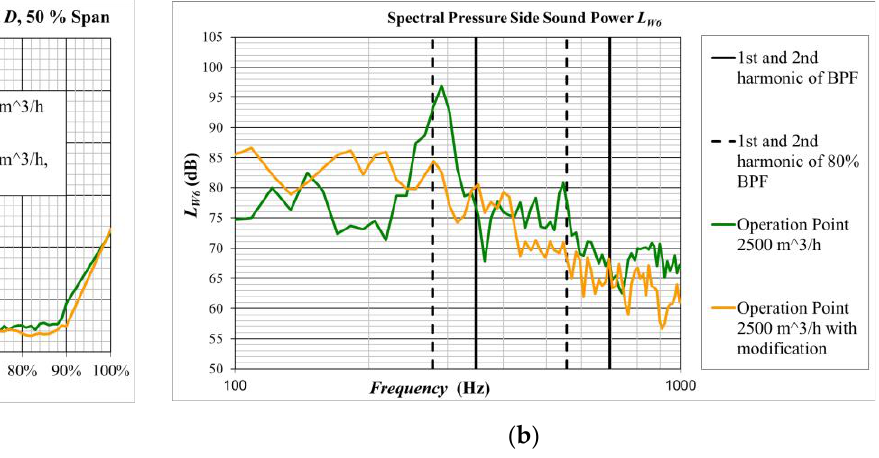
Figure 8. Correlation of rotating structures and sound spectre: ( a ) modal analysis of rotating structures; ( b ) spectral content of Pressure Side Sound Power Level L W6 .